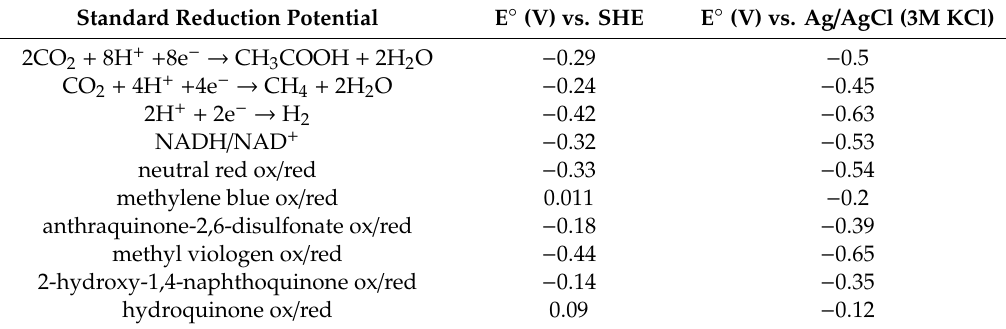
Figure 1. Acetate production during eight cycles of electrosynthesis using 0.1 mM of each redox mediator. The arrow indicates replenishment of the headspace gas in a batch operation. The potential ( − 1.11 V vs. Ag/AgCl (3M KCl)) was applied continuously to the cathode electrode using a potentiostat. NR: neutral red; HNQ: 2-hydroxy-1,4-naphthoquinone; HQ: hydroquinone. Table 1. Standard reduction potential of possible cathode reaction and redox mediators at pH 7 [11,27,28,33–37].